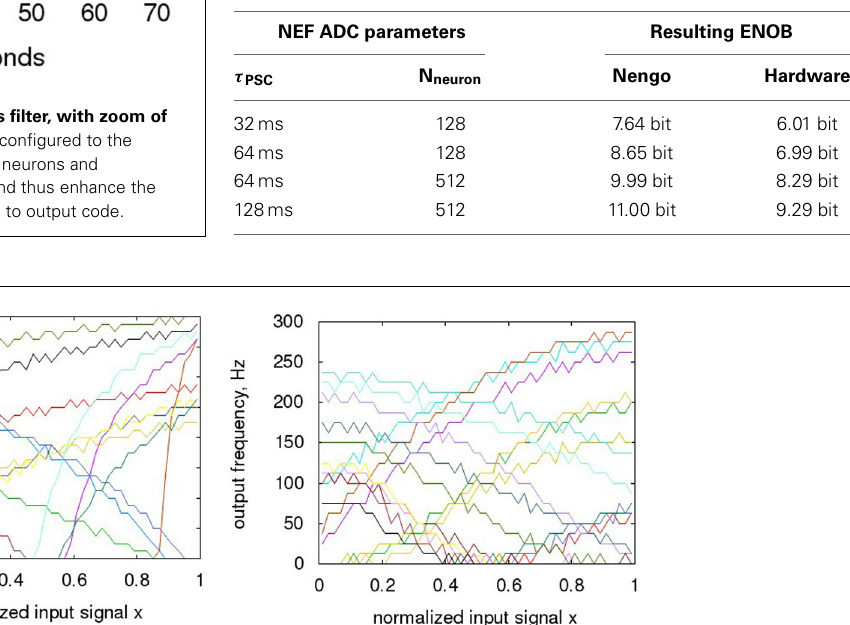
Table 4 | ENOB-comparison for two examples Nengo and HW: τ PSC sweep and N neuron sweep.